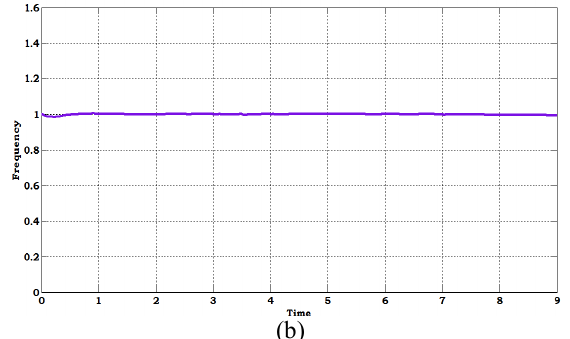
Figure 13. (a). DC link voltage, (b).Frequency Even in islanded mode also fuzzy controller is maintaining constant DC link voltage and frequency.